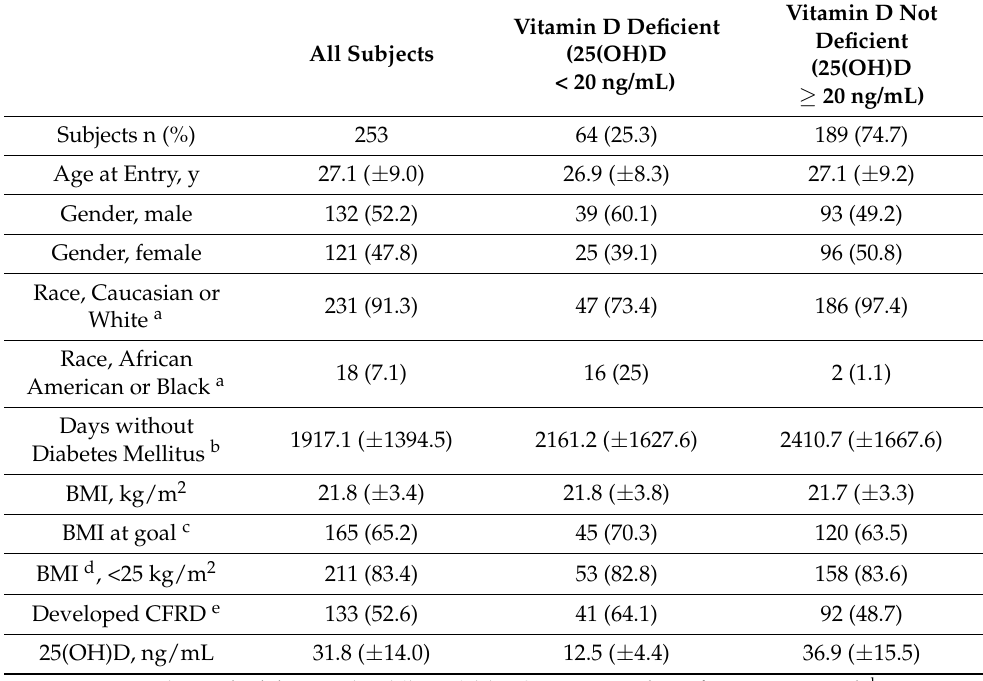
Table 1. Baseline subject demographics stratified by vitamin D deficiency at 20 ng/mL.